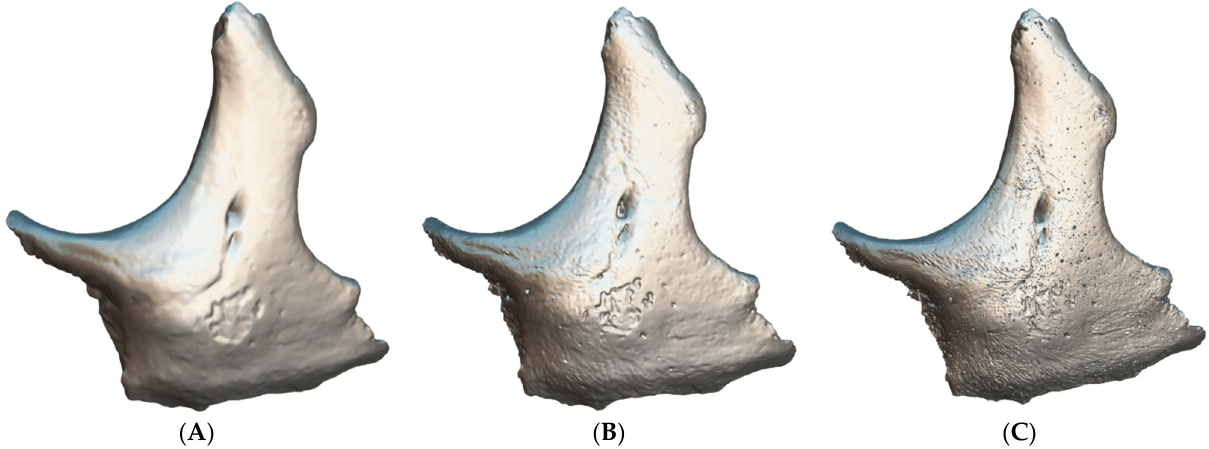
Figure 1. 3D model’s simplified and optimized polygon meshes created by using different techniques. ( A ) 3D scanning, ( B ) photogrammetry, ( C ) micro-computed tomography.